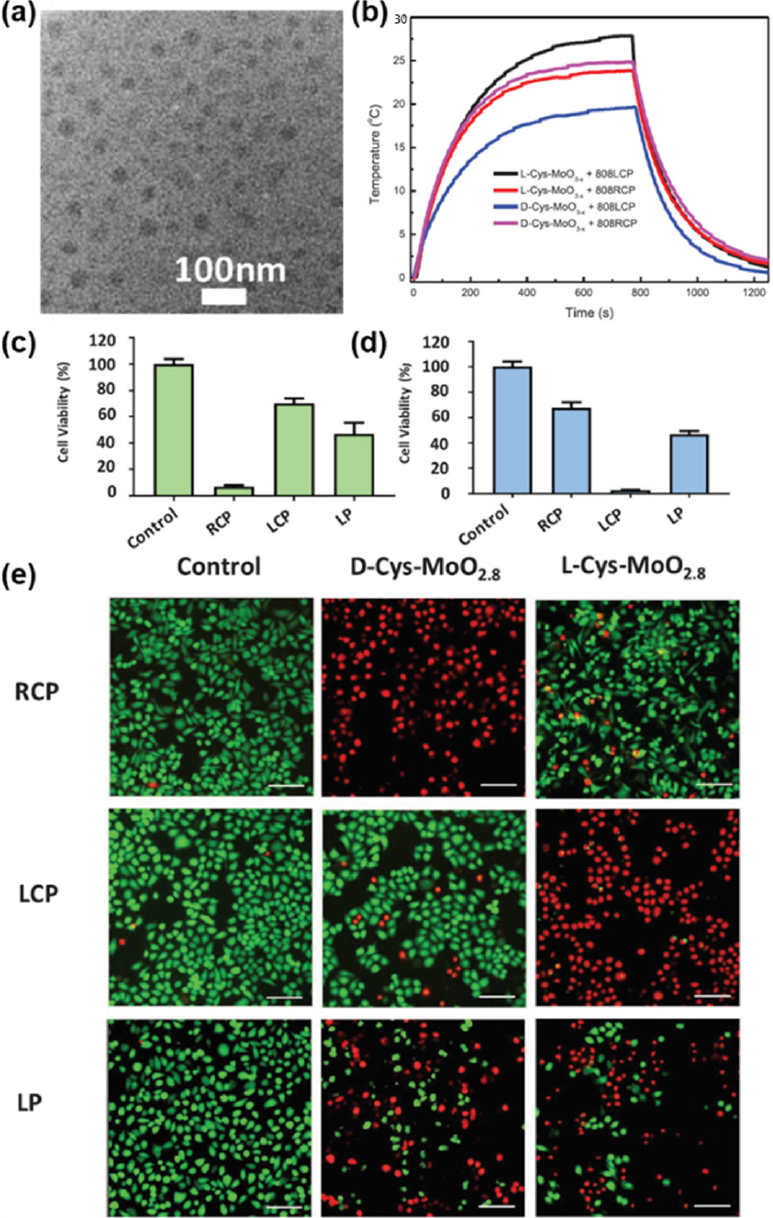
Figure 7. ( a ) TEM image of L- Cys-MoO 3 − x NPs. ( b ) Temperature versus time curves of L- /D-Cys- MoO 3 − x NPs under 808 nm LCP/RCP radiation. ( c ) The viability of HeLa cells incubated with D-Cys-MoO 3 − x NPs and ( d ) L- Cys-MoO 3 − x NPs. ( e ) Fluorescence microscopy images of live (green) and dead (red) HeLa cells after RCP, LCP and LP light irradiation, scale bar = 100 µ m. Reprinted with permission from Ref. [24]. Copyright 2019 John Wiley and